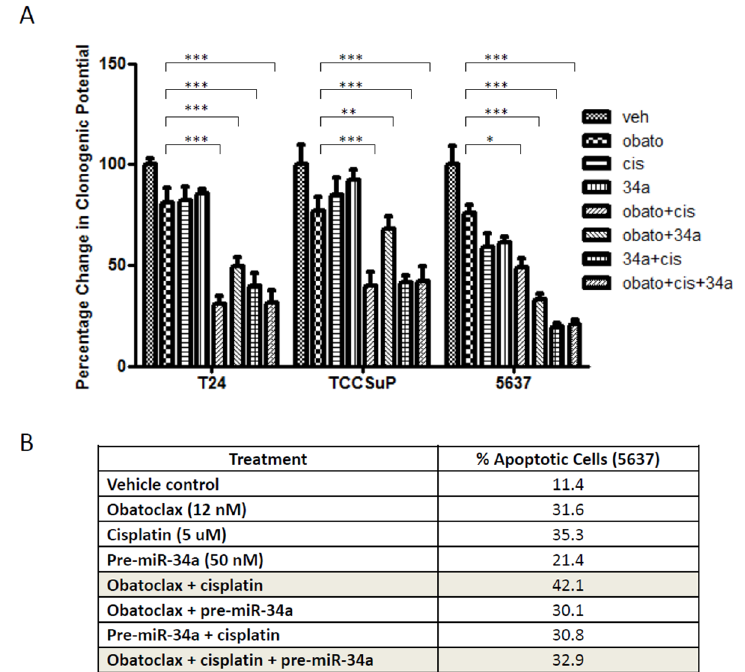
Figure 3. Combining Obatoclax with cisplatin further reduces clonogenic potential and further increases apoptosis. The inclusion of pre-miR-34a in combination treatments can abrogate pro-apoptotic effects. Treatment with Obatoclax as a single agent caused a reduction of clonogenicity in all 3 MI-BC cell lines ( p < 0.001 for all 3 cell lines) (T24, TCCSuP, and 5637 were treated with IC 30 value concentations of Obatoclax; 25, 60, and 40 nM, respectively) ( A ); Further reductions were observed when Obatoclax was combined with cisplatin (5 µ M), the standard of care treatment for MI-BC (~2.5-fold ( p < 0.001), ~2.0-fold ( p < 0.001), and ~1.5-fold ( p < 0.05) reductions were observed in T24, TCCSuP, and 5637, respectively). Combining Obatoclax with pre-miR-34 treatment also caused further reductions in clonogenicity compared to treatment with Obatoclax or pre-miR-34a as single agents (~1.7-fold ( p < 0.001), ~1.2-fold ( p < 0.01), and ~2.0-fold ( p < 0.001) reduction, respectively). In T24 and TCCSuP, the Obatoclax + cisplatin outperformed the Obatoclax + pre-miR-34a treatment (~2.0-fold ( p < 0.05), ~1.2-fold ( p < 0.05) reduction, respectively), but the reverse was true in 5637 cells (~2-fold ( p < 0.001) reduction). Combining cisplatin with pre-miR-34a, or combining all 3 treatments (Obatoclax + cisplatin + pre-miR-34a) did not result in any further reduction in clonogenicity compared to Obatoclax + cisplatin. Apoptosis assays conducted using 5637 cells demonstrated that the Obatoclax + cisplatin outperformed any of the other treatments ( B ). It is noteworthy that combining pre-miR-34a with Obatoclax + cisplatin caused a dramatic decrease in apoptosis compared to treatment with Obatoclax + cisplatin (32.9% compared to 42.1%, respectively). (Veh = vehicle control, Cis = cisplatin, 34a = pre-miR-34a, Obato = Obatoclax). (* = p < 0.05, ** = p < 0.01, *** = p < 0.001)